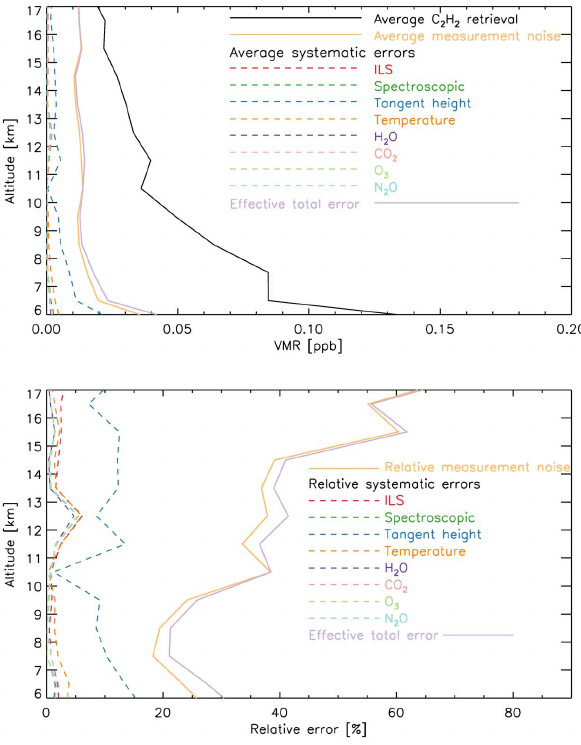
Fig. 4. Top panel: Mean VMR profile of C 2 H 2 (black) for the 25 occultations selected for the error budget calculations and the absolute value of the contribution of each component. Lower panel: Relative contribution of each of the components considered in the error budget calculation. In purple in both panels is the effective total